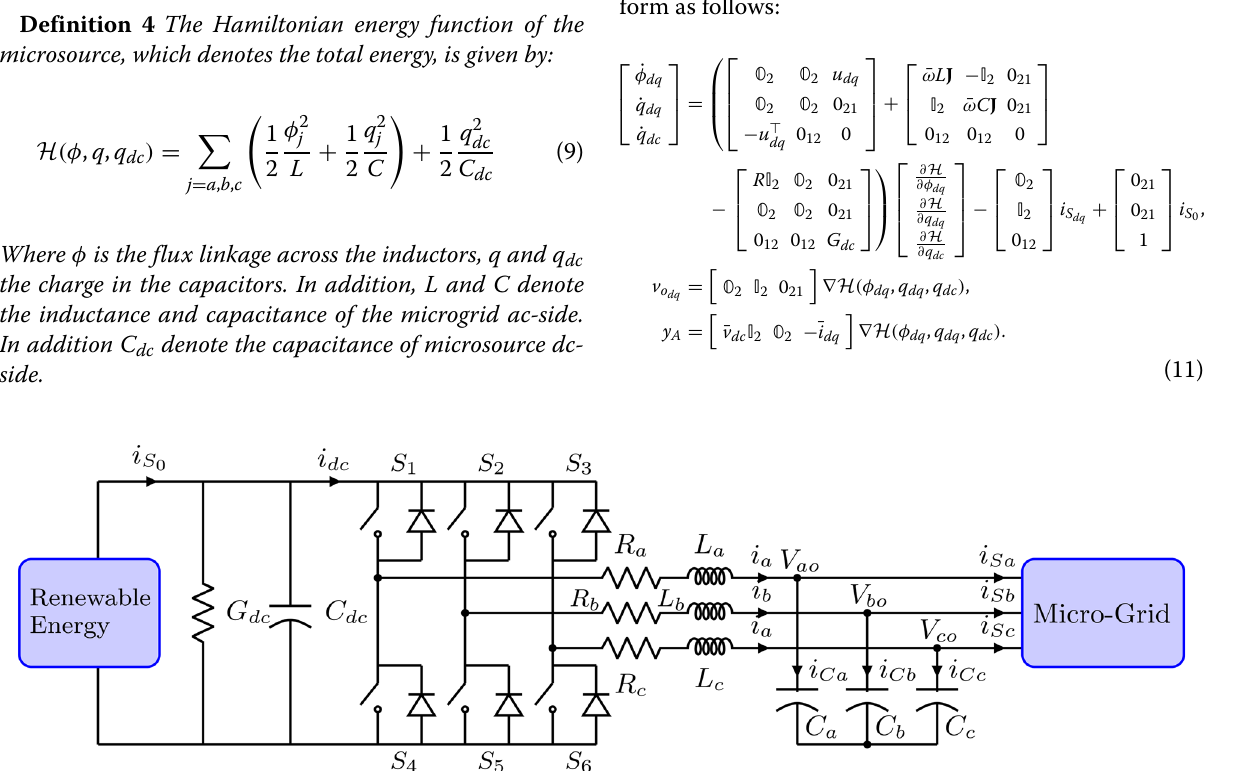
Fig. 2 The microsource equipped with three-phase